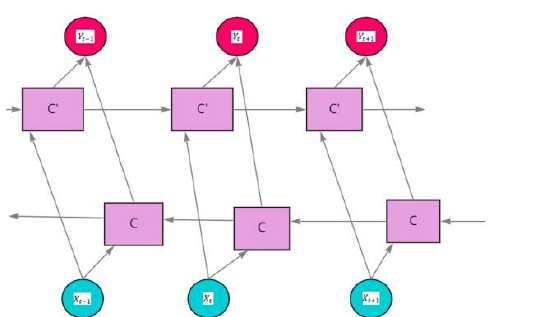
Figure 12. CNN model.